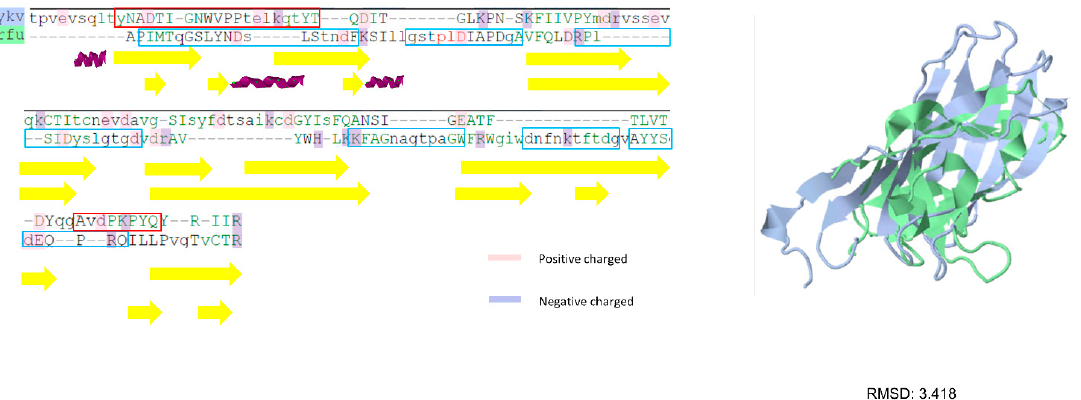
Figure 5. Sequence alignment between betanodavirus (PDB:4RFU) and gammanodavirus (PDB:5YKV). P-domain of betanodavirus and gammanodavirus are sequentially and structurally aligned. The alignment is annotated by secondary structures (helix, turn, and strand) acquired from DSSP.